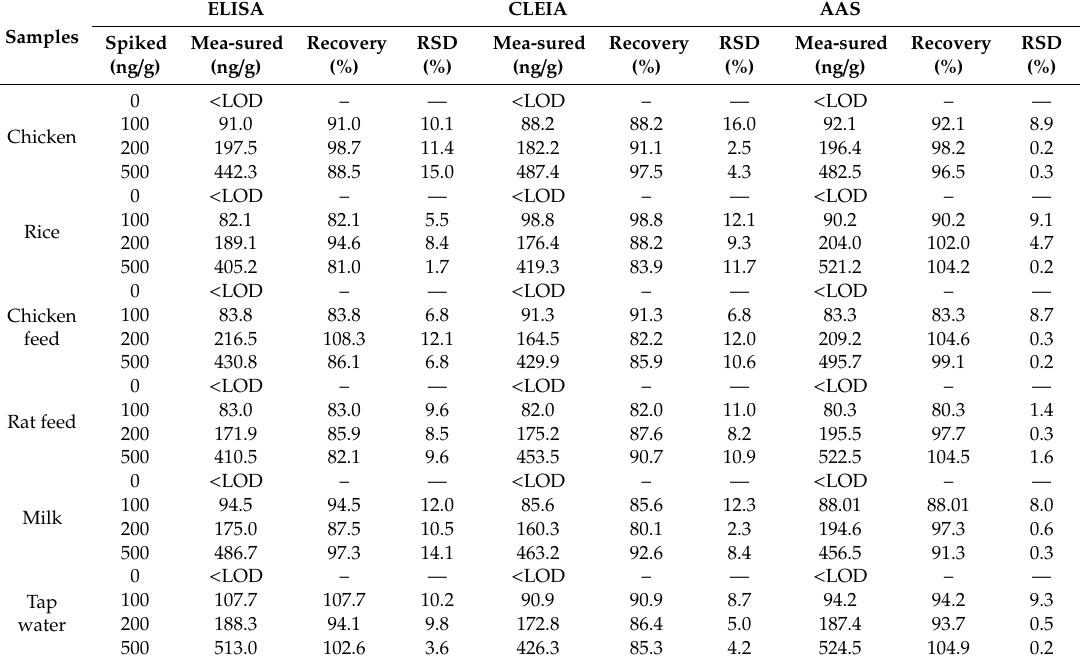
Table 3. Recovery ratio of Pb 2+ from different samples ( n = 4).